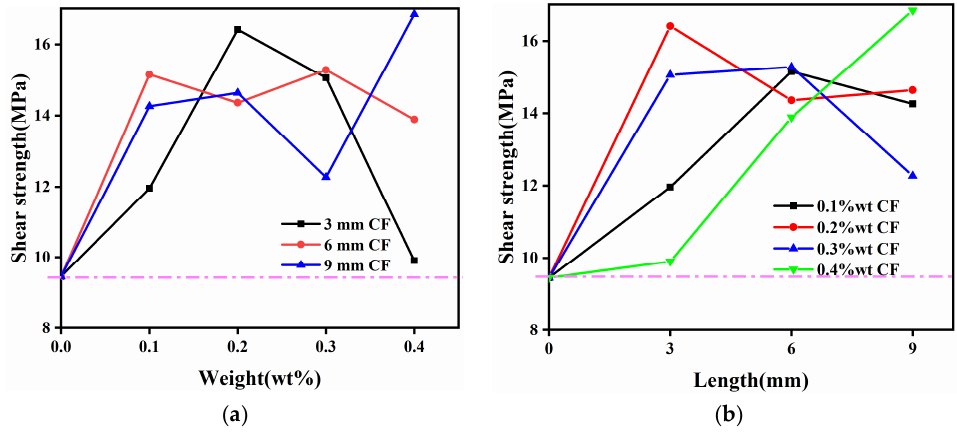
Figure 7. Shear strength changed with the added CF weight percentage ( a ) and the length ( b ).